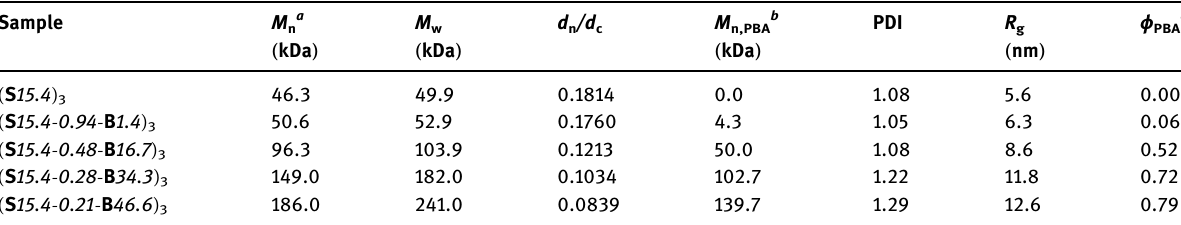
Table 1: Molecular structure parameters of the ( S x ) 3 and the star block copolymer ( S x - b - B y ) 3